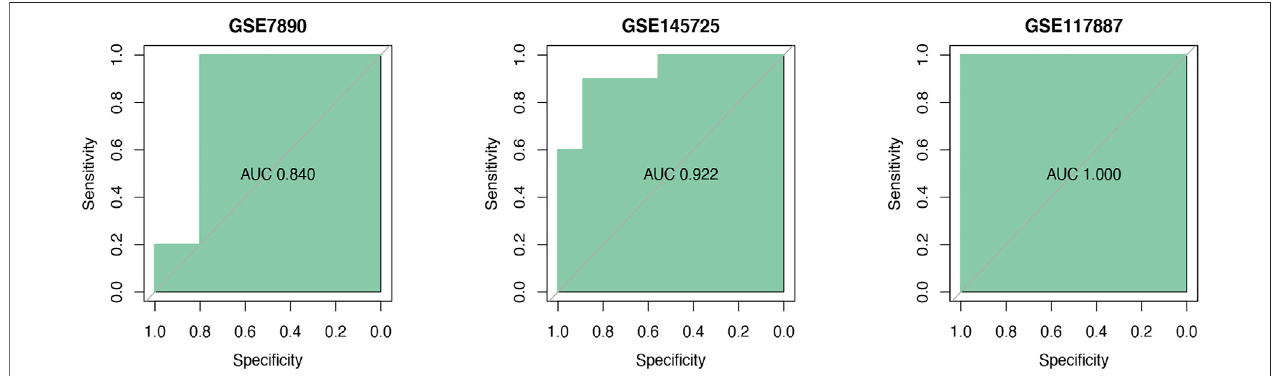
Frontiers in Molecular Biosciences |